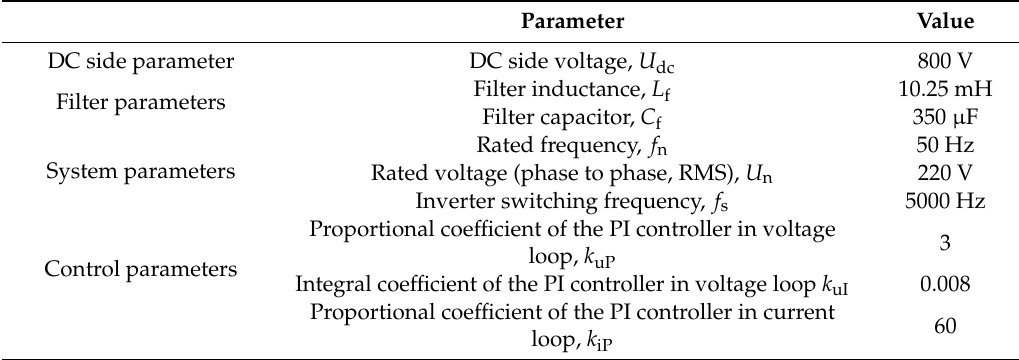
Table 1. Simulation